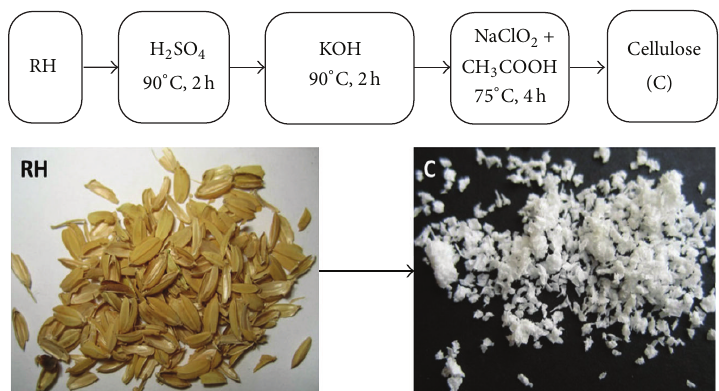
Figure 17: Schematic representation of the cellulose extraction from RH [36].